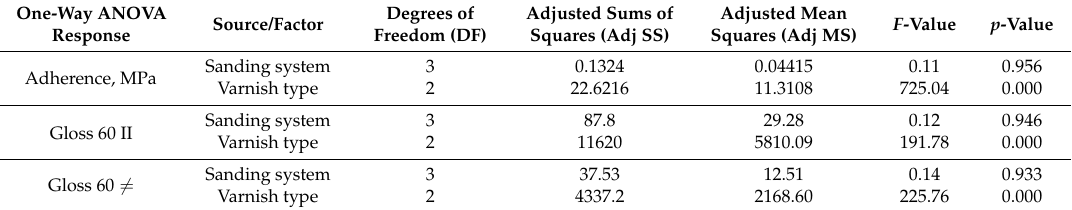
Table 5. One-way ANOVA analysis of adherence and gloss as a function of the sanding system and varnish. One-Way ANOVA Response